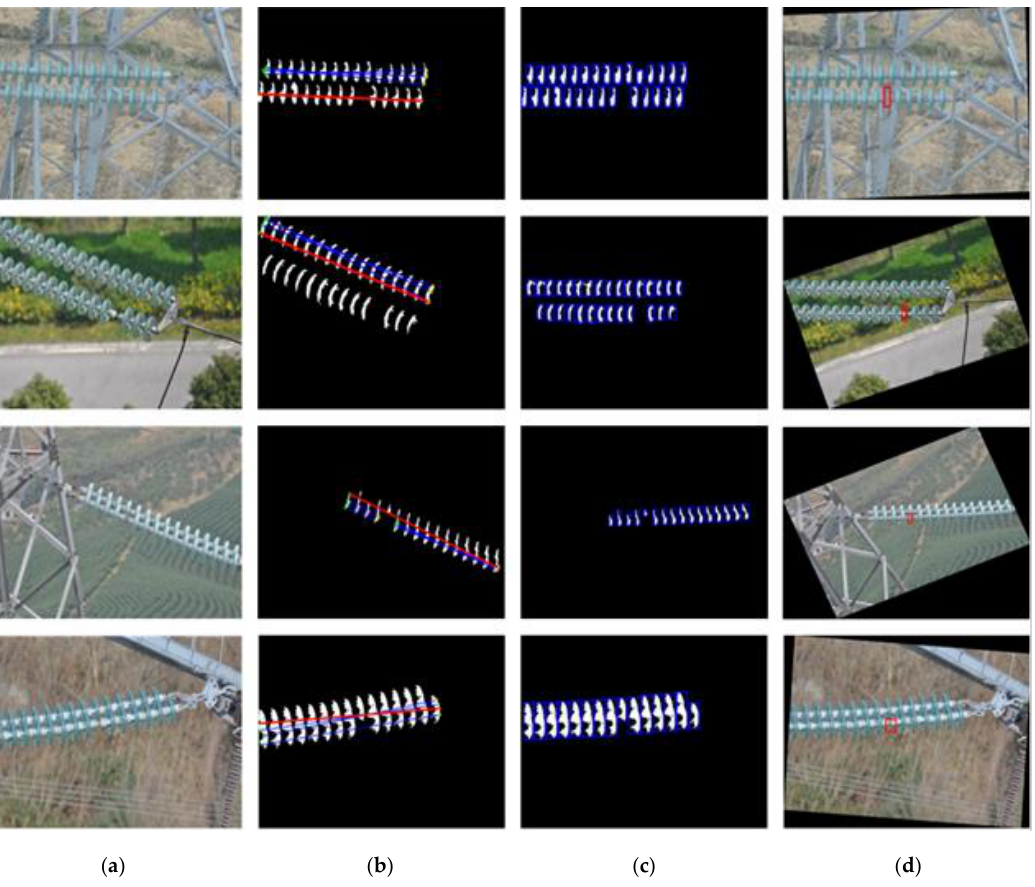
Figure 8. Test results: ( a ) Original image; ( b ) Detected lines; ( c ) Connected regions; ( d ) Defect localization.